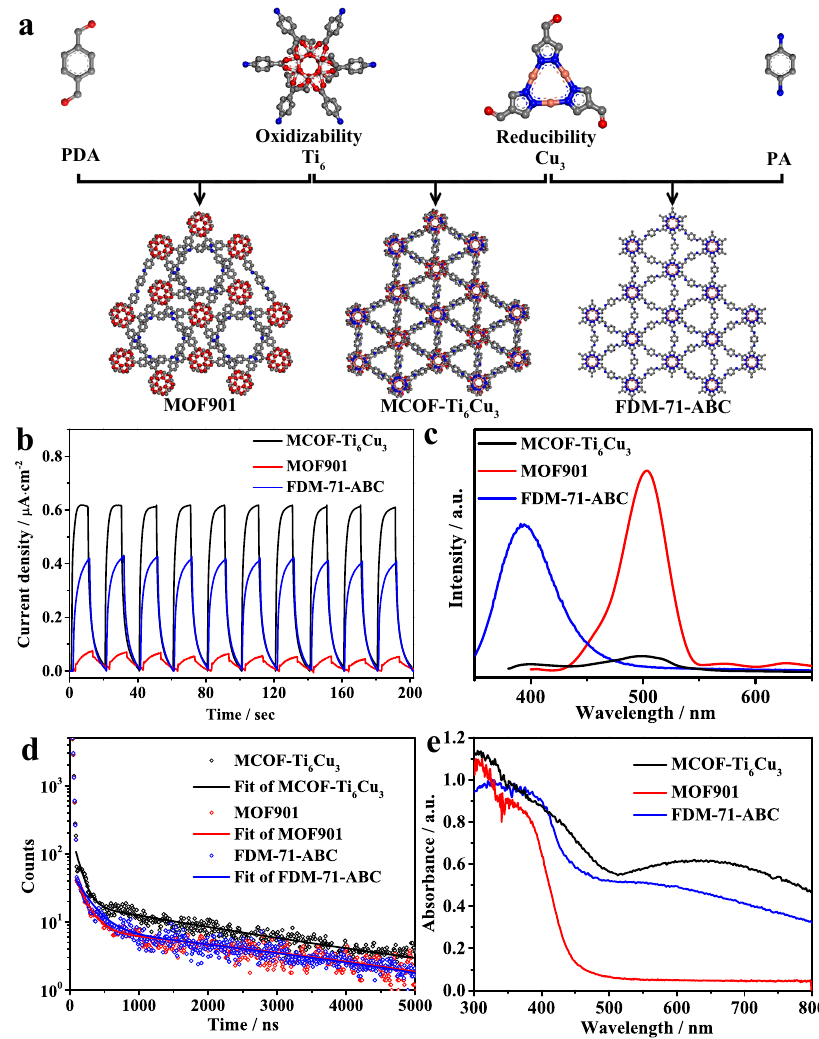
Fig. 2| Comparisonsfor photochemicalproperties. a Schematicof thesynthesis ofMOF901,FDM-71-ABC,andMCOF-Ti 6 Cu 3 .PhotoelectricalPropertiesofMOF901,